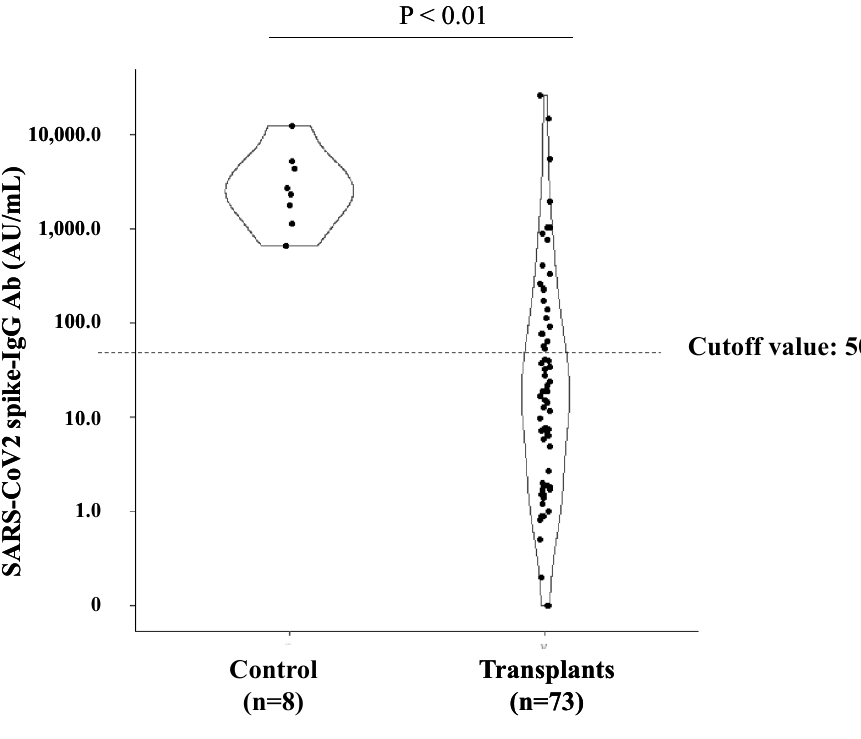
Figure 2. Quantification of antibody titers in participants in the post-kidney transplantation and control groups. The dots indicate the values of SARS-CoV2 spike-IgG Antibodies. The dotted line indicates the cutoff